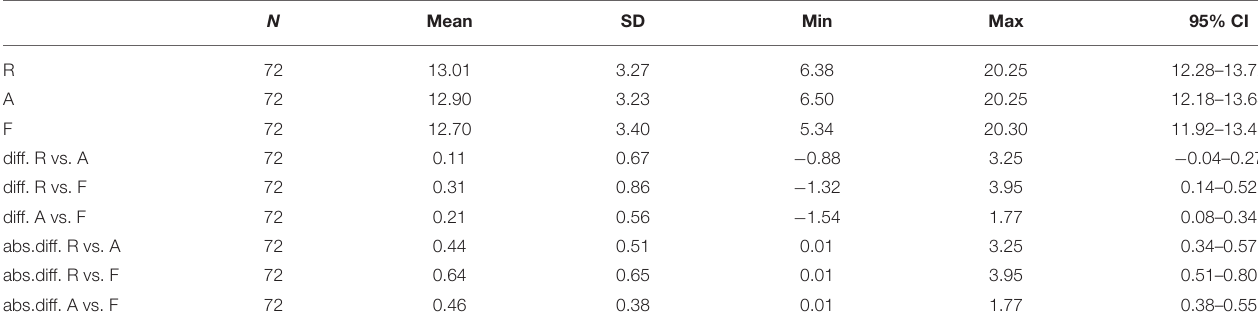
TABLE 2 | Mean spherical equivalent refractive values (in diopters) obtained by retinoscopy (R), automatic refractometry (A) and vergence formula (F), and the differences between each